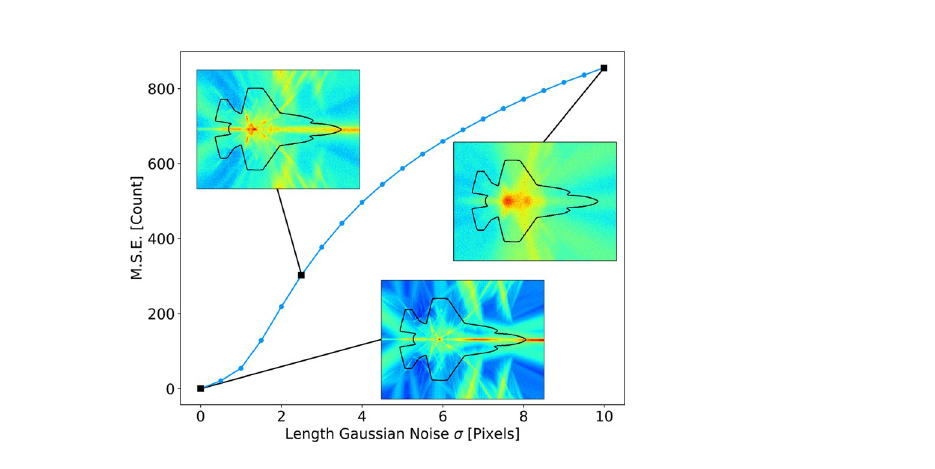
Figure 8. Guassian noise added to each measure of distance increases the mean squared error (MSE) when compared to the zero noise case. For noise with standard deviation less than or equal to the bin size (in this case 1), output MSE is only slightly impacted with a maximum MSE of 53. For noise with standard deviation greater than the bin size, MSE increases steeply before leveling as the noise standard deviation reaches ten times the bin size, and the relative change in the output density with increasing noise power is